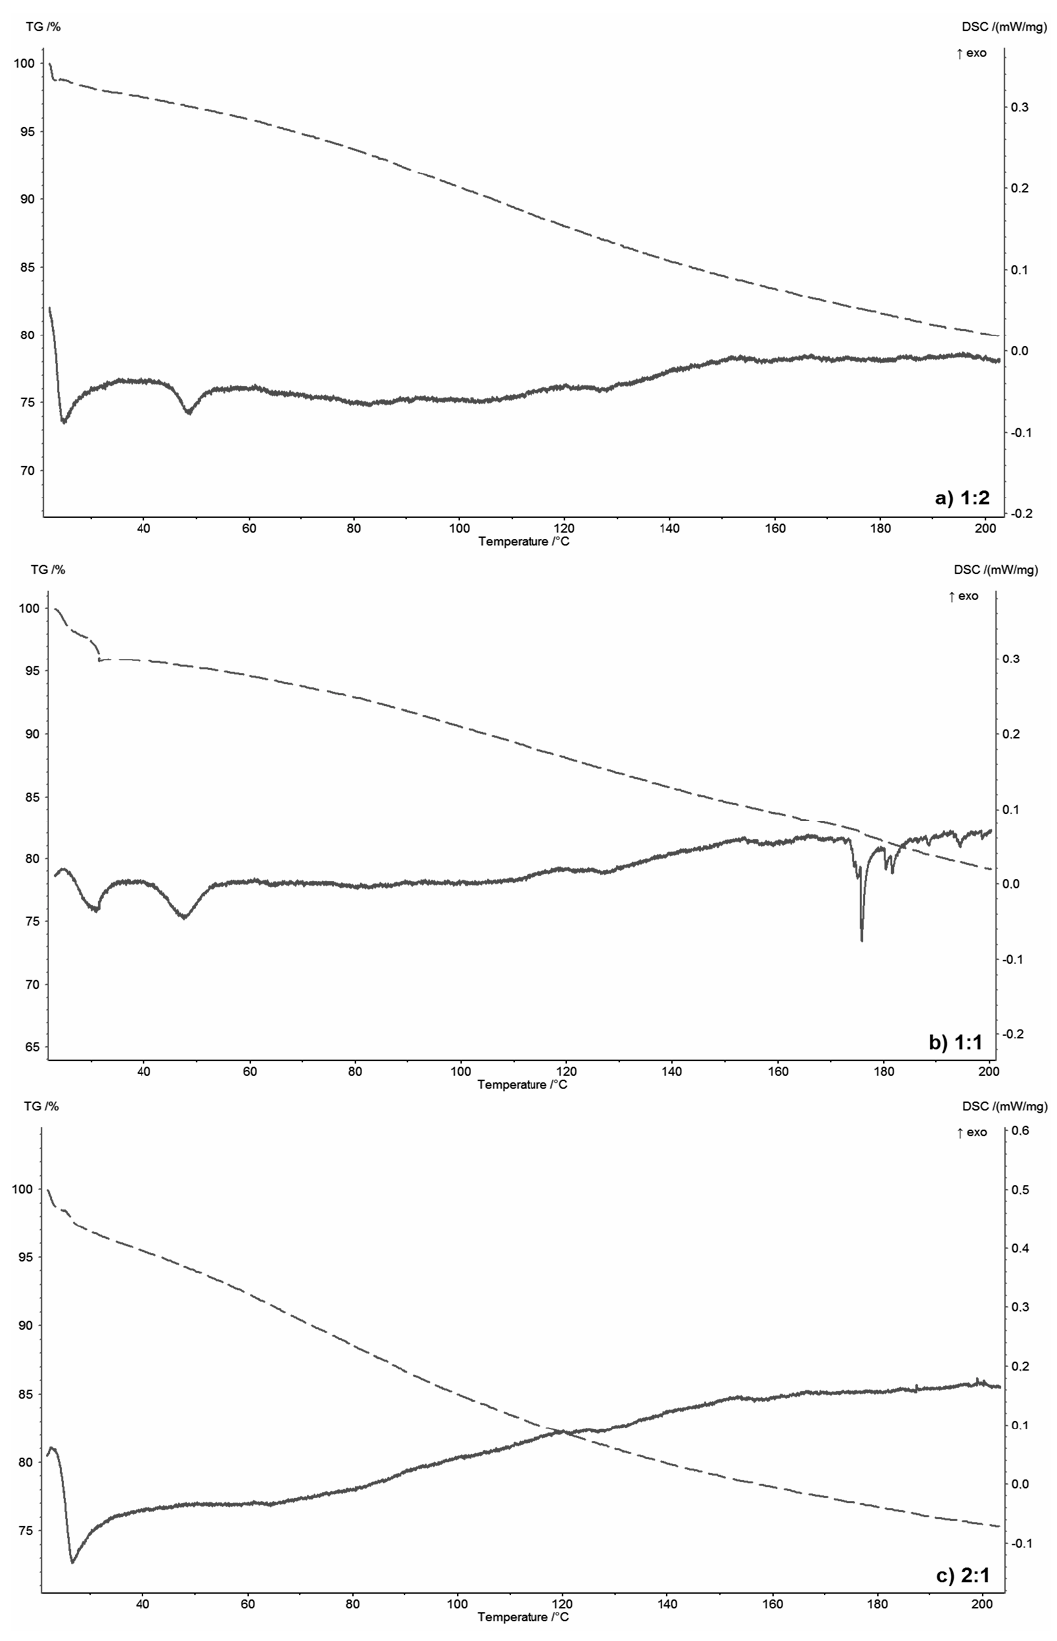
Figure 2. TG / DSC thermograms of the selected polymer-silicate hydrogels with the mass ratio of sodium water glass to polymer: ( a ) 1:2, ( b ) 1:1, ( c ) 2:1.